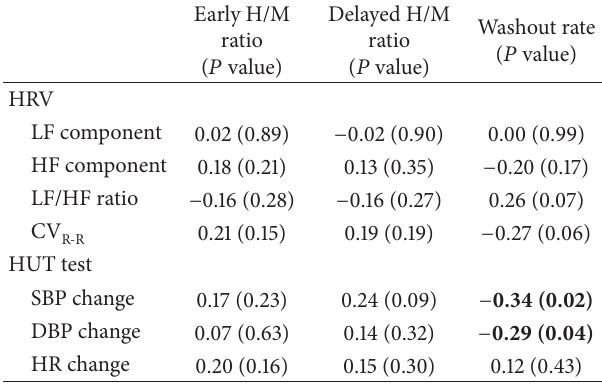
Table 2: Correlation between MIBG scintigraphy and autonomic function